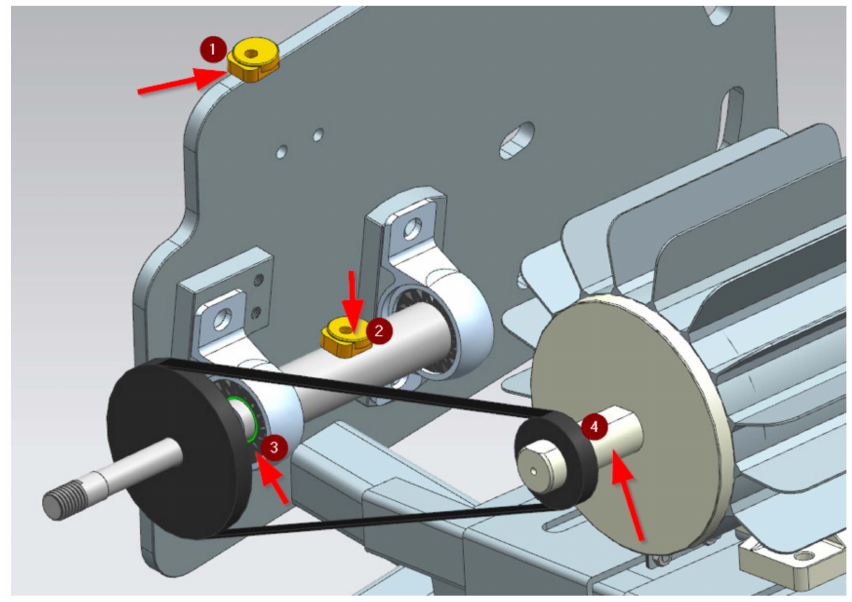
Figure 3. Test stand and equipment: 1—VSA003 reference sensor, 2—VSA003 sensor, 3—PLA-TPU bushing, 4—motor